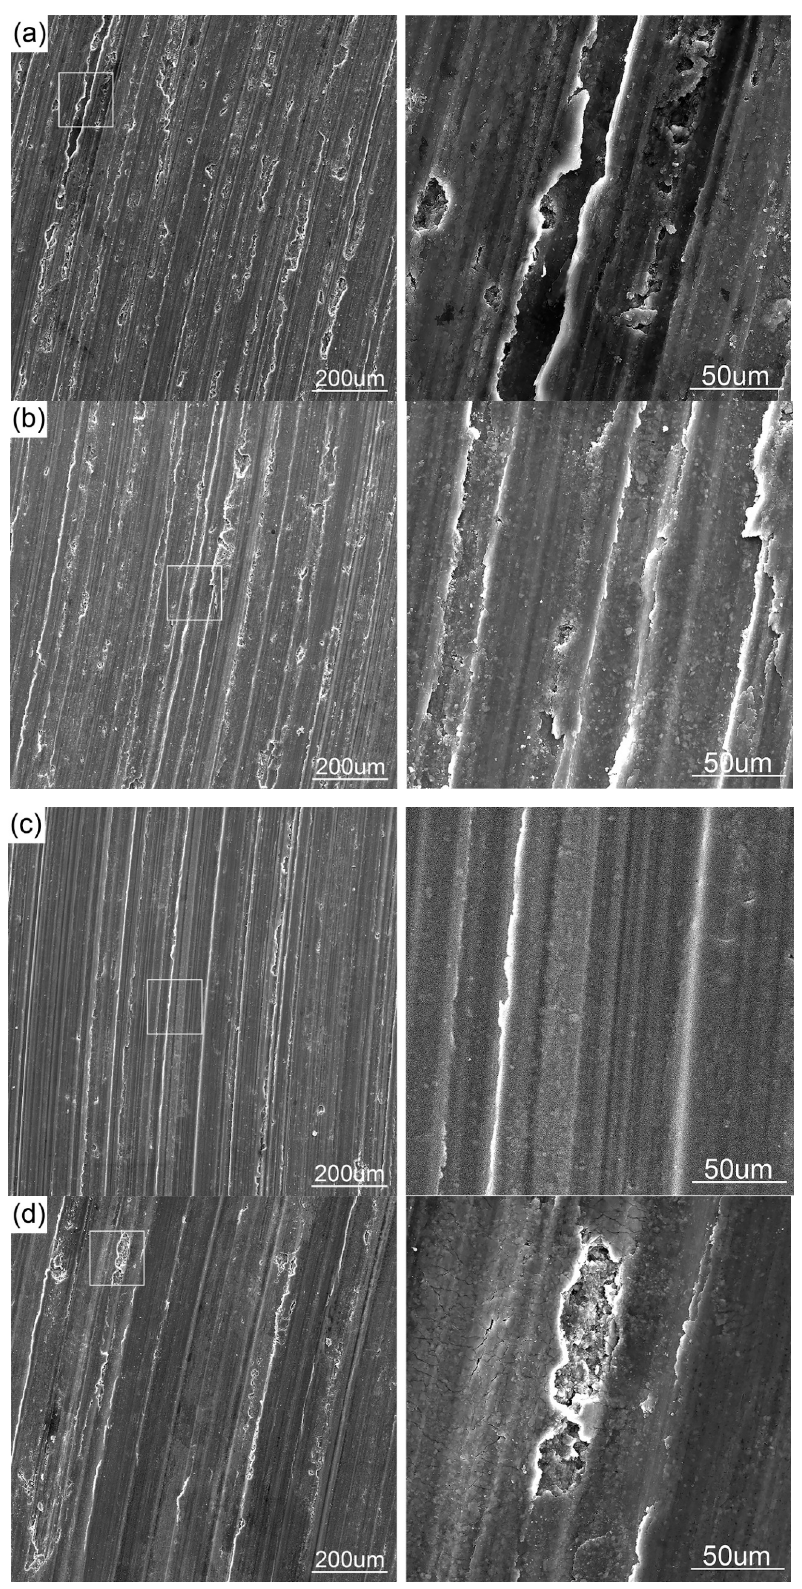
Figure 10. SEM micrographs of worn out surfaces for ( a ) AlSi5Cu1Mg; ( b ) AlSi5Cu1Mg + 0.3 wt % La; ( c ) AlSi5Cu1Mg + 0.6 wt % La; ( d ) AlSi5Cu1Mg + 0.9 wt % La alloys subjected to 0.19m/s sliding velocity and 3.8 MPa normal load, and the high magnification micrographs are on their right side.